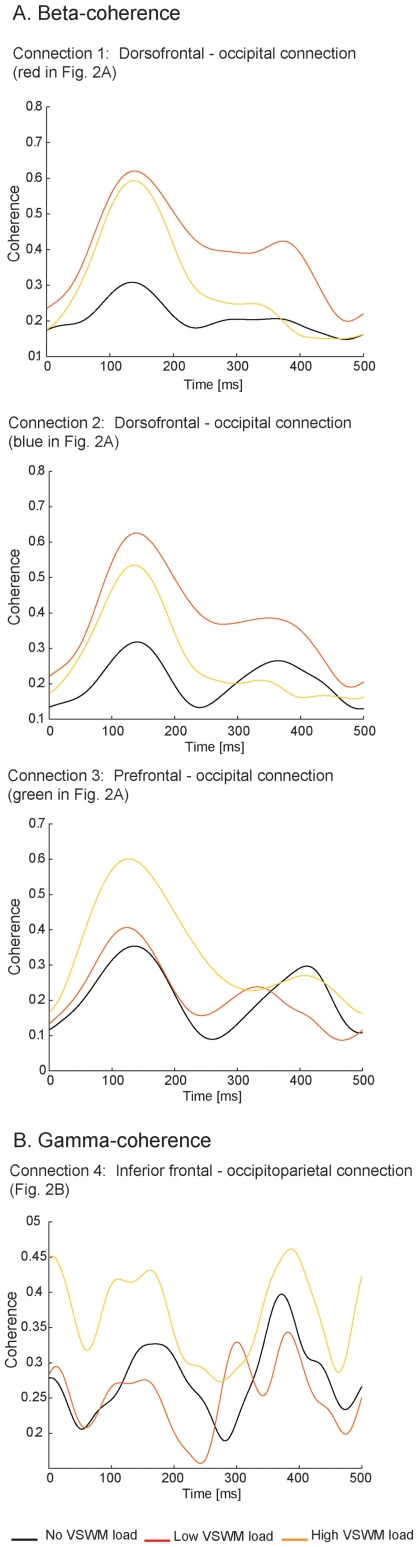
Evolution of coherence as a function of time during grid perception.Change in coherence in the four functional brain connections of interest as a function of time during grid perception. Black lines: baseline trials; orange lines: low VSWM load trials; yellow lines: high VSWM load trials.